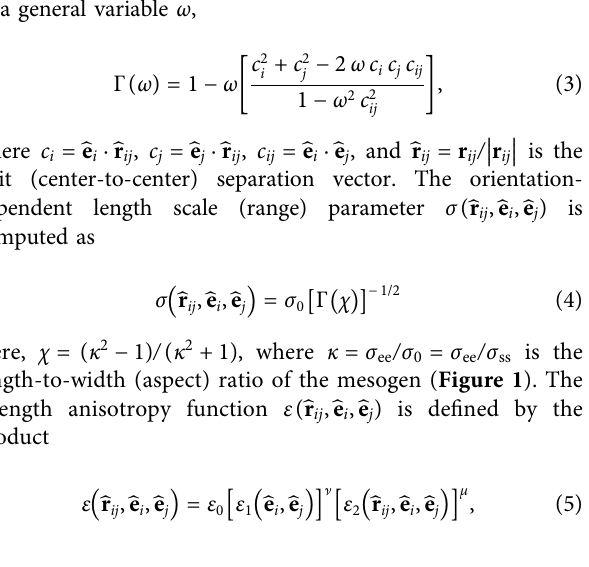
Frontiers in Physics |